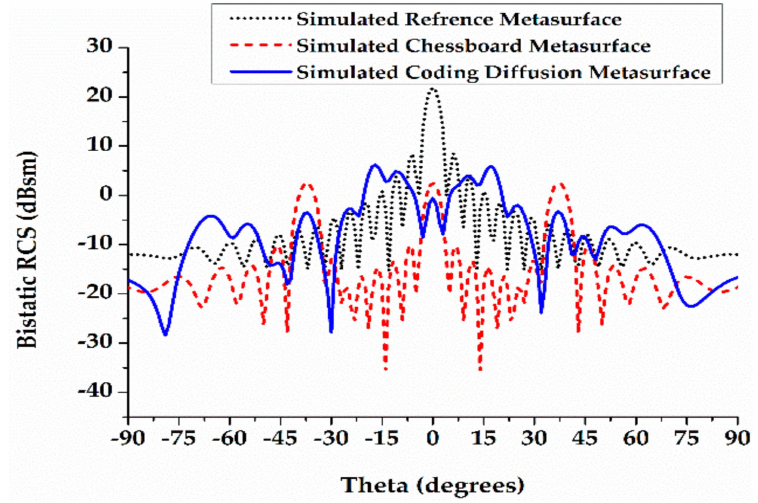
Figure 9. Bi-static RCS reduction of a chessboard and coding di ff usion